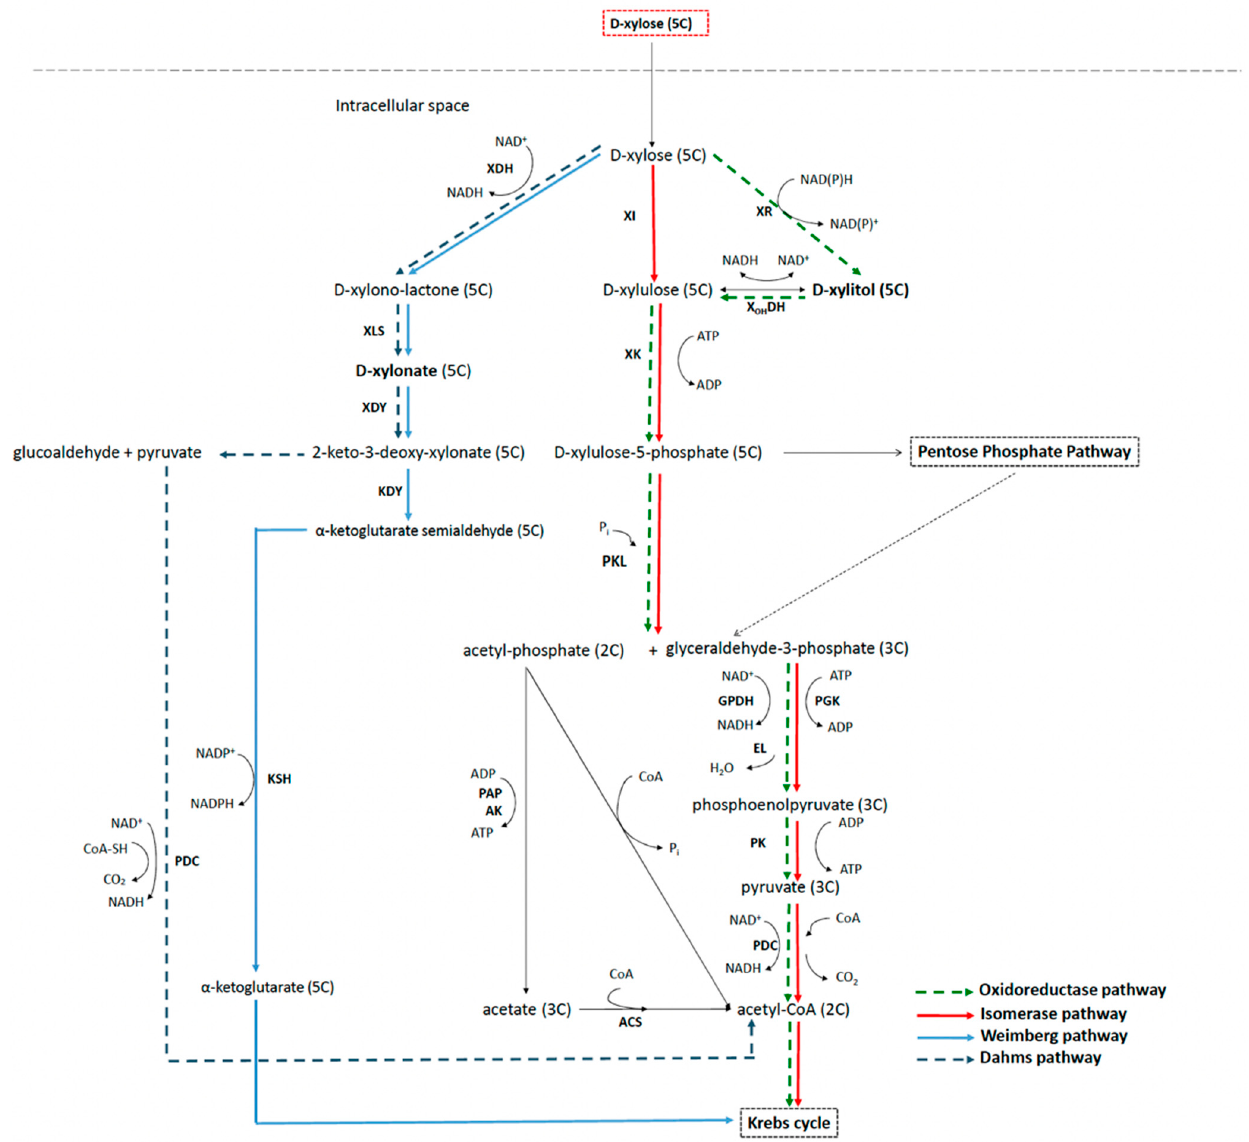
Figure 1. Three pathways of xylose metabolization by microorganisms: solid light blue, Weinberg pathway; dashed dark blue, Dahms pathway; dashed green, oxidoreductase pathway; and solid red, isomerase pathway. The enzymes are abbreviated as follows: acetyl-CoA synthase (ACS); acetate kinase (AK); enolase (EL); glyceraldehyde-3-phosphate dehydrogenase (GPDH); 2-keto-3-deoxyxylonate dehydratase (KDY); α -ketoglutarate semialdehyde dehydrogenase (KSH); pyrophosphate-acetate phosphotransferase (PAP); pyruvate dehydrogenase complex (PDC); 3-phosphoglycerate kinase (PGK); phosphoketolase (PK); phosphoketolase (PKL); xylonate dehydratase (XDY); xylose dehydrogenase (XDH); xylitol dehydrogenase (X OH DH); xylose isomerase (XI); xylulokinase (XK); xylonolactonase (XLS); and xylose reductase (XR). Adapted from [79,80].